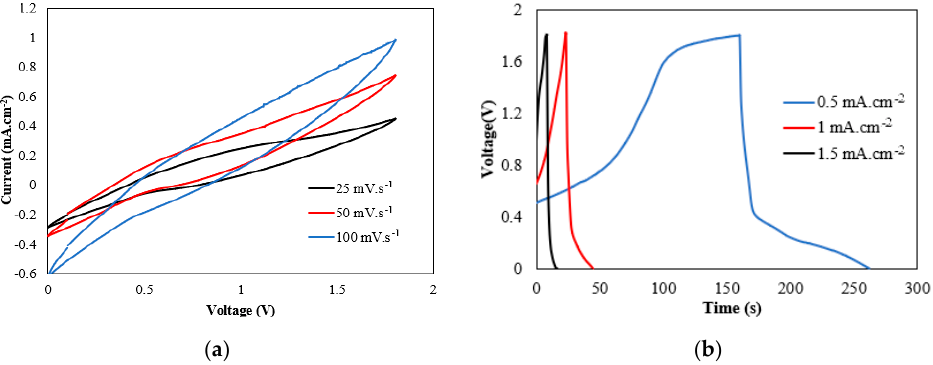
Figure 3. ( a ) CV tests between 0 and 1.8 V at the scan rates of 100, 50 and 25 mV·s − 1 . ( b ) GC tests between 0 and 1.8 V at the cycling currents of 0.5, 1 and 1.5 mA·cm − 2 .